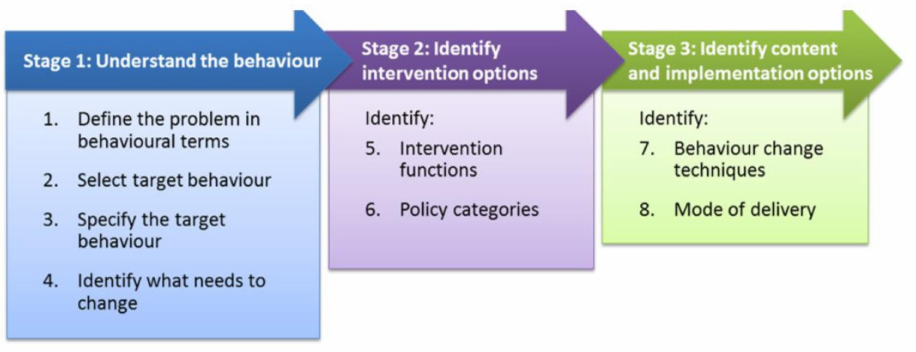
Figure 6. The steps in the Behaviour Change Wheel framework